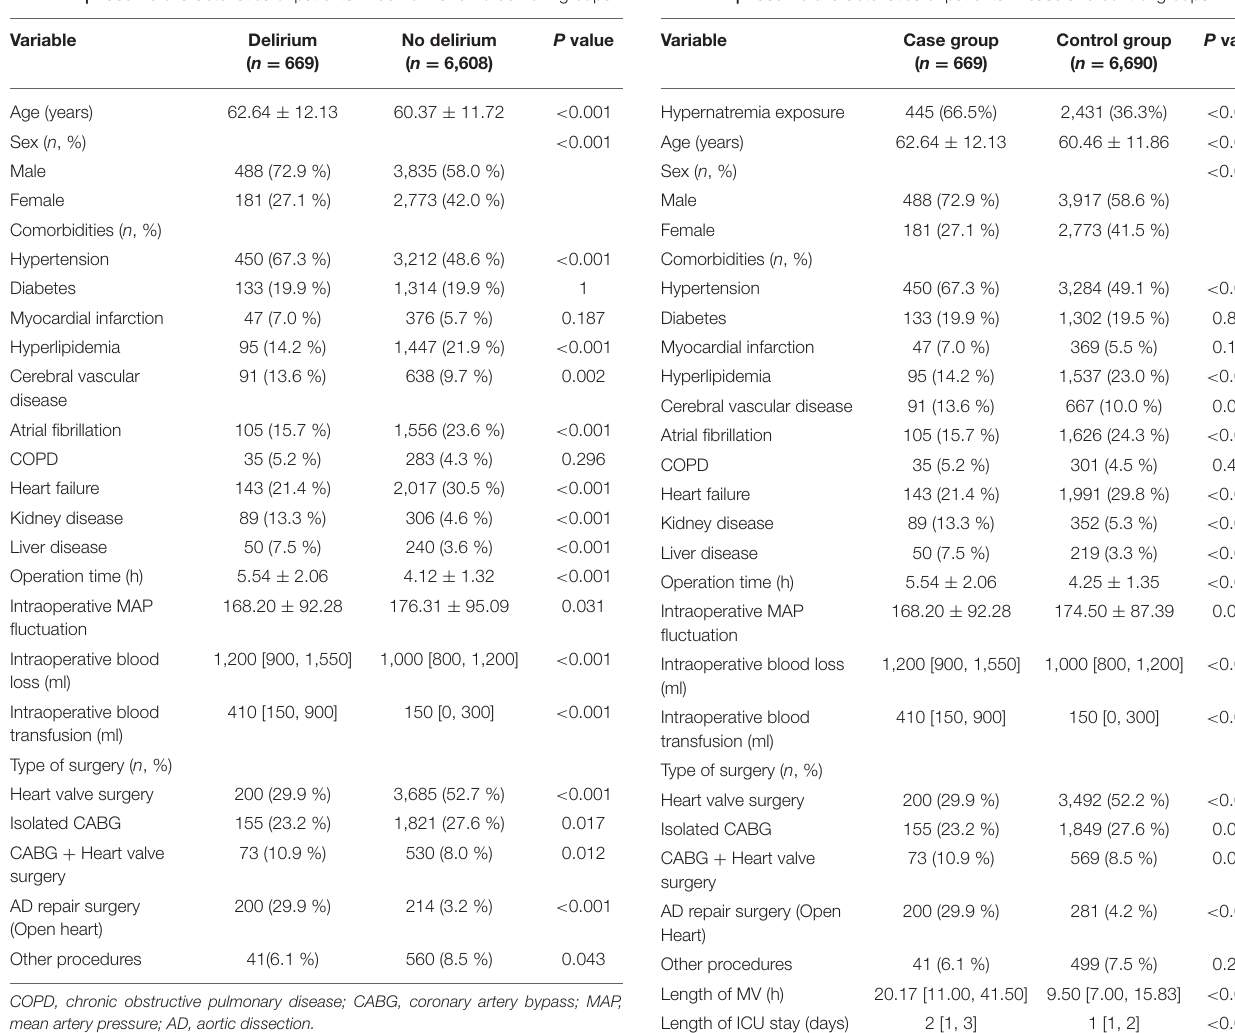
TABLE 1 | Baseline characteristics of patients in delirium and no delirium groups. TABLE 2 | Baseline characteristics of patients in case and control